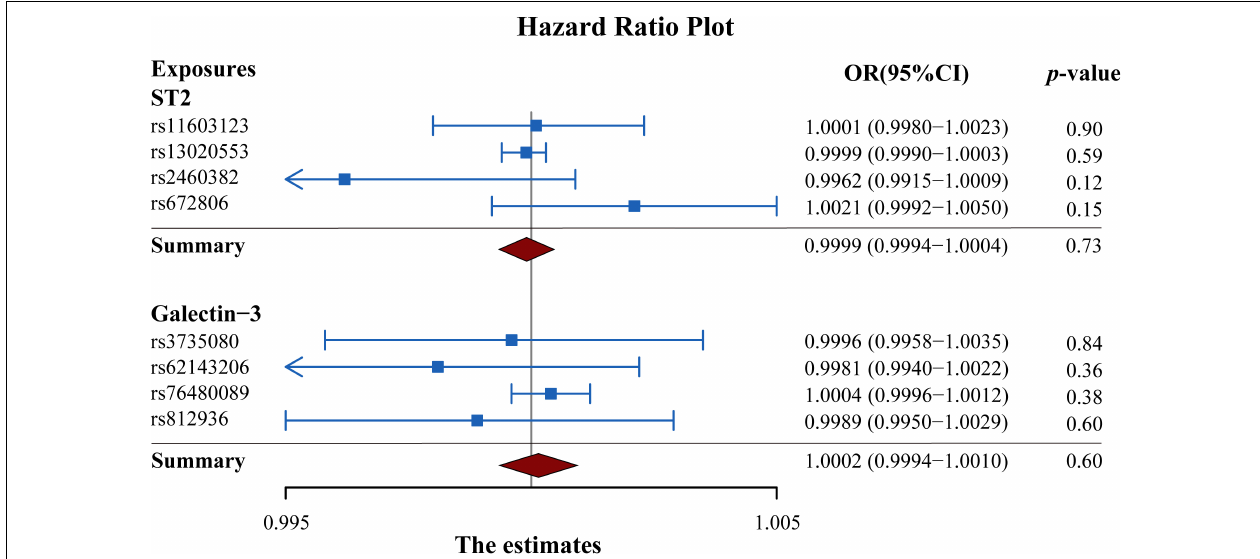
FIGURE 3 | Forest plot summarizing the overall MR estimates of SNP specificity and the causal effect on heart failure. Estimated odds ratios represent the effect per standard deviation increase in circulating ST2 and galectin-3 levels on heart failure, respectively. Results were obtained from the fix-effect IVW method. Squares represent the estimated ORs, and horizontal lines represent the 95% CI of the ORs. MR, Mendelian randomization; SNP, single-nucleotide polymorphism; IVW, inverse variance weighted; OR, odds ratio; CI, confidence interval.